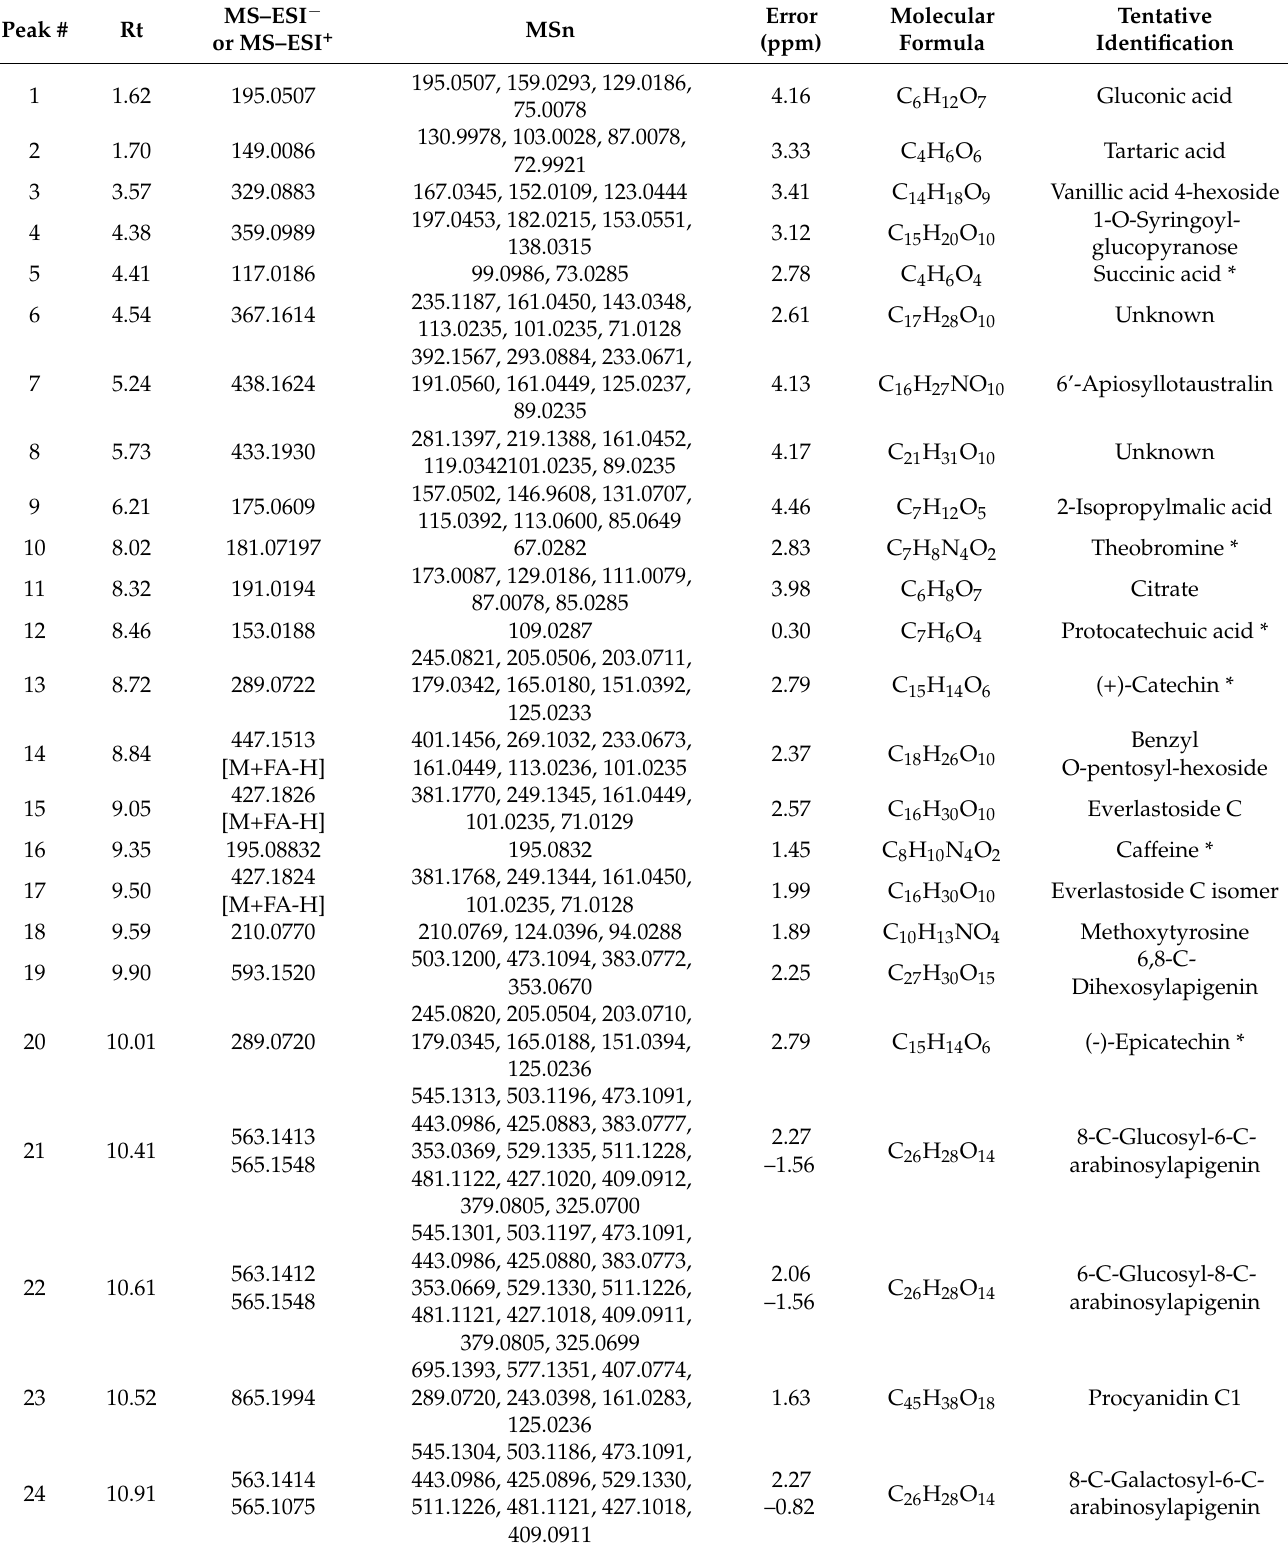
Table 1. High resolution UHPLC–PDA-Q orbitrap identification of metabolites in vein and pod husk flours of